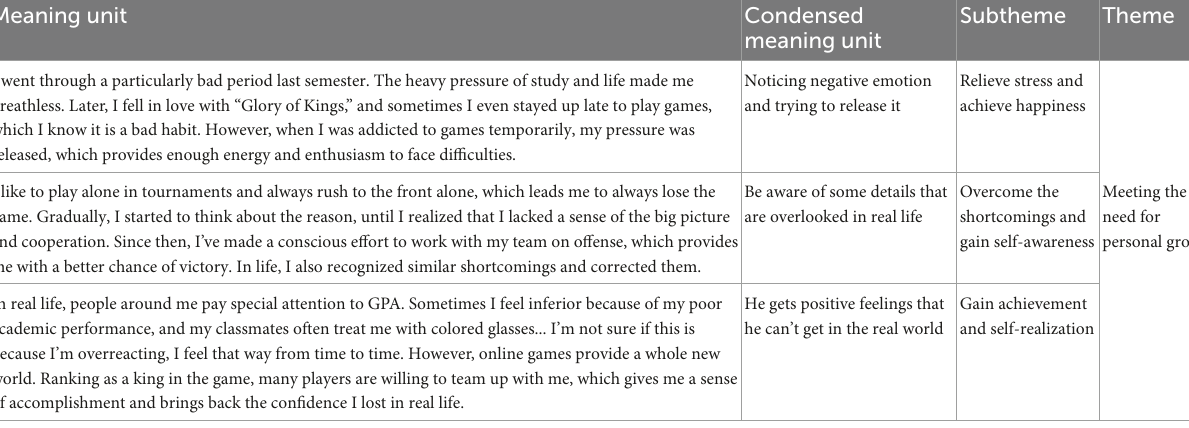
TABLE 2 Thematic analysis of transcribed data from interviews with 20 people with the online game “Glory of Kings”. Meaning